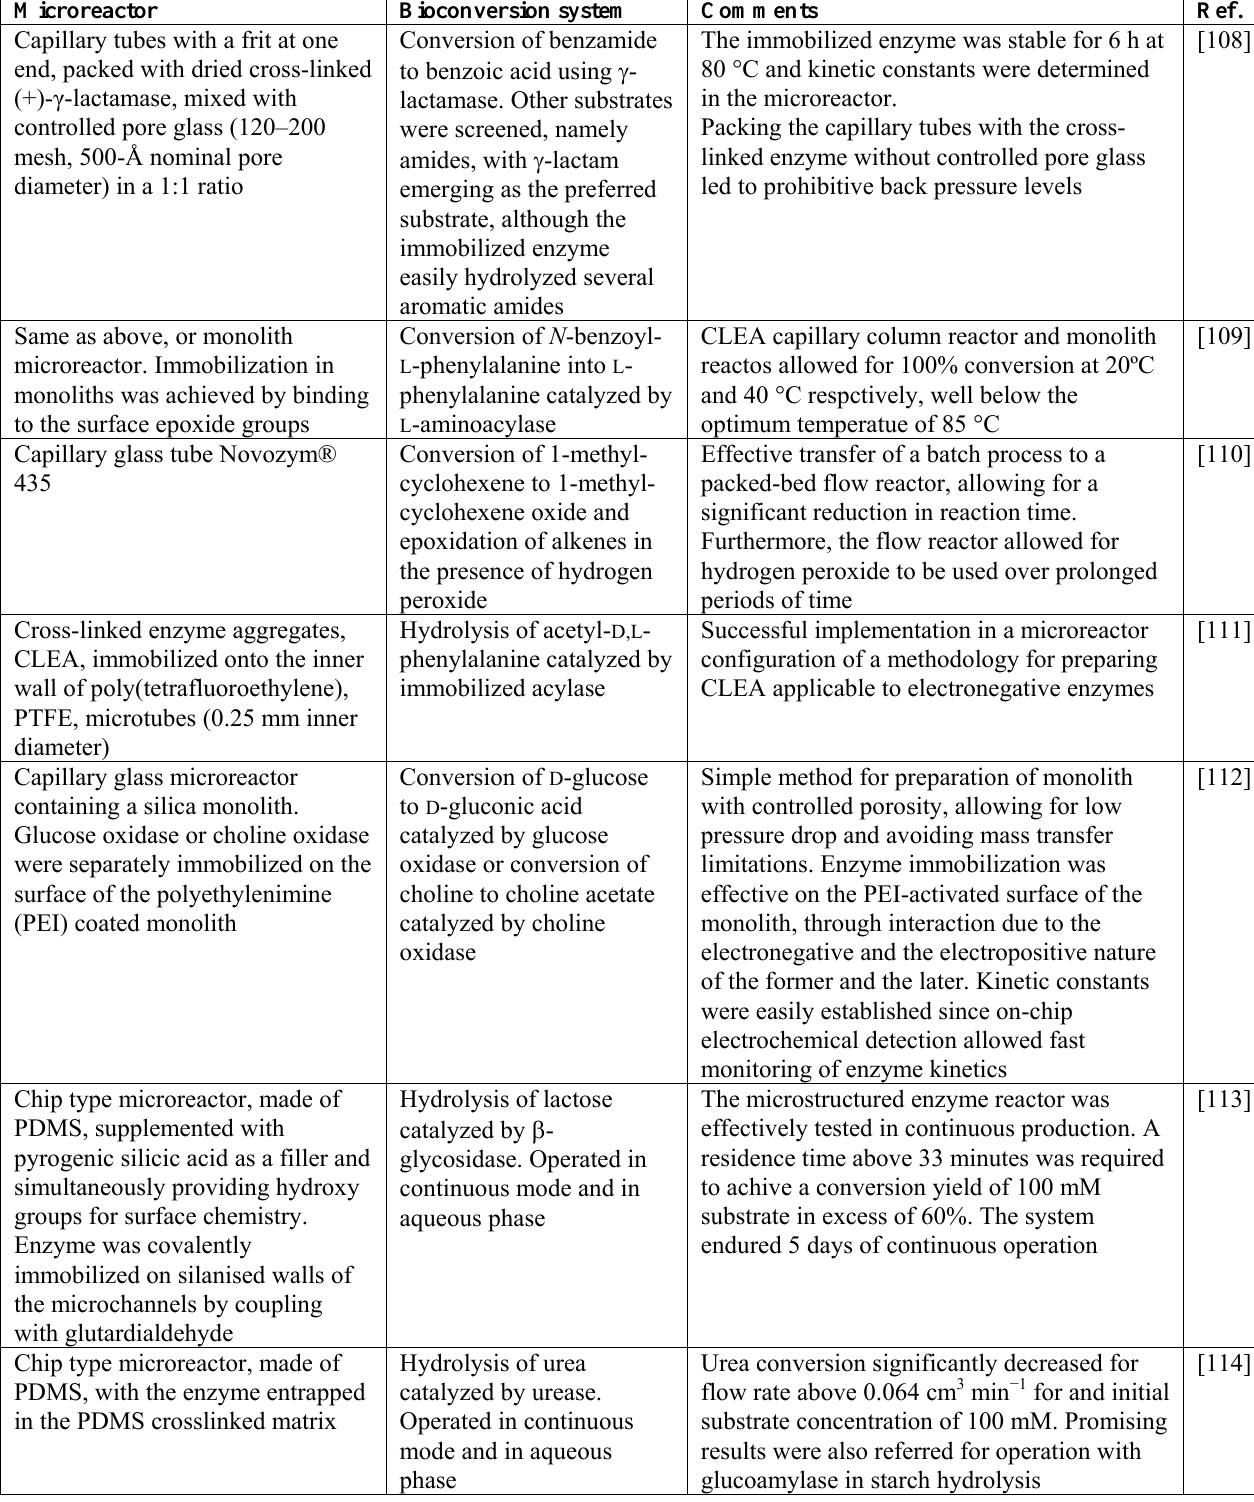
Table 4. Examples of microfluidic systems with immobilized